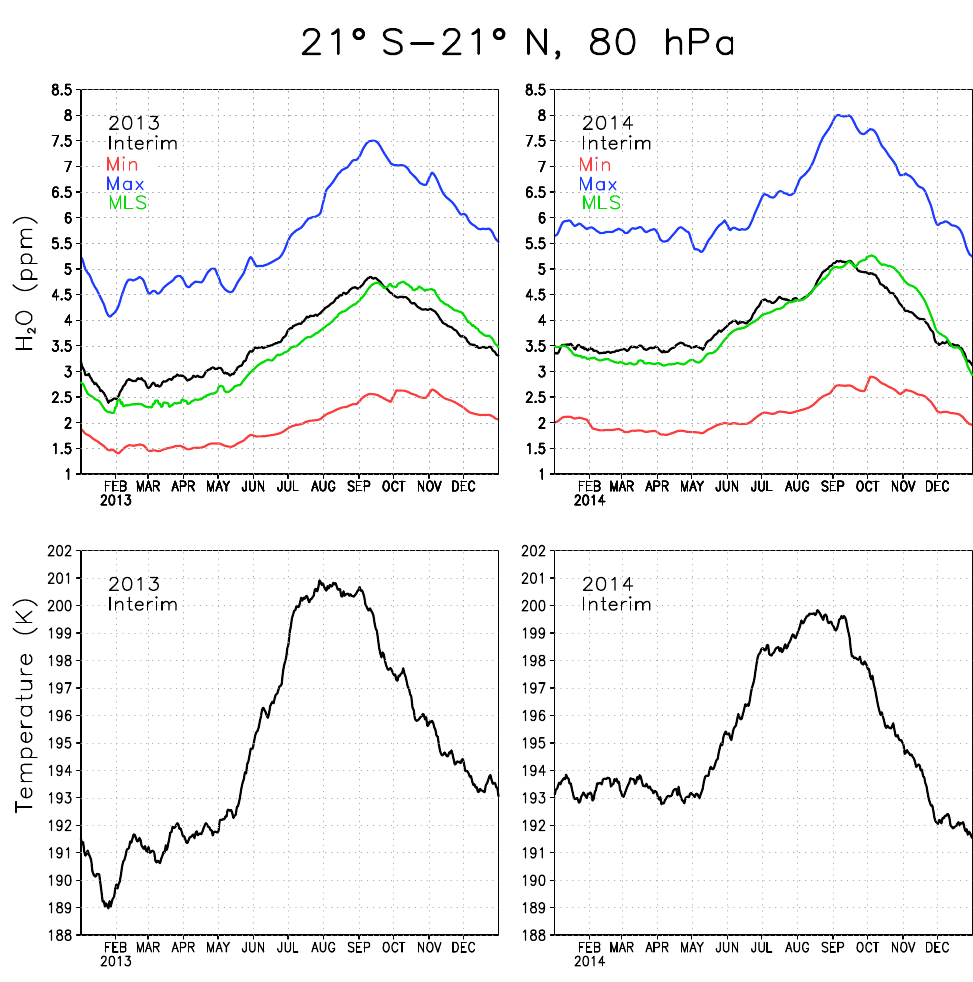
Figure 1. Water vapour and temperature around the tropical tropopause between 21 ◦ S and 21 ◦ N at level 80hPa in 2013 and 2014. The green line denotes the Interim simulation, blue denotes the Max simulation, red denotes the Min simulation and black denotes the